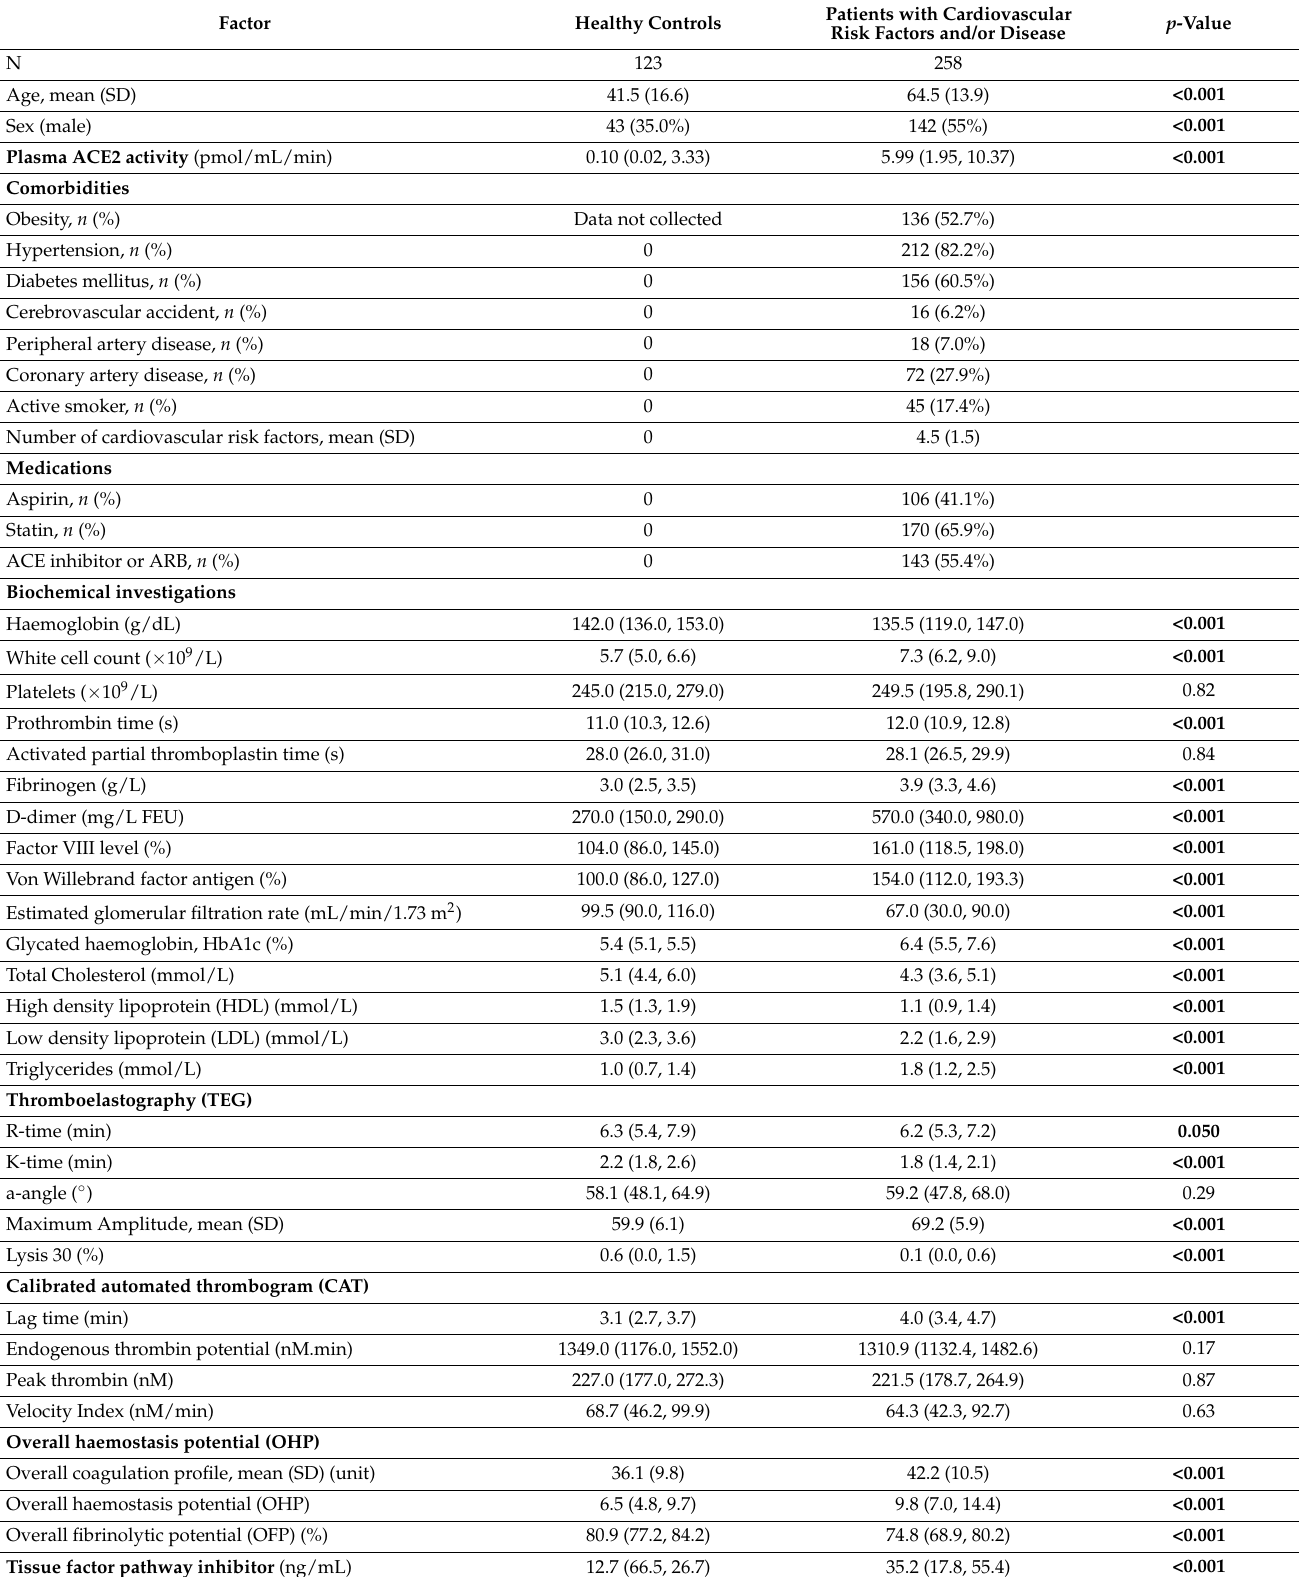
Table 2. Healthy controls compared to patients with cardiovascular risk